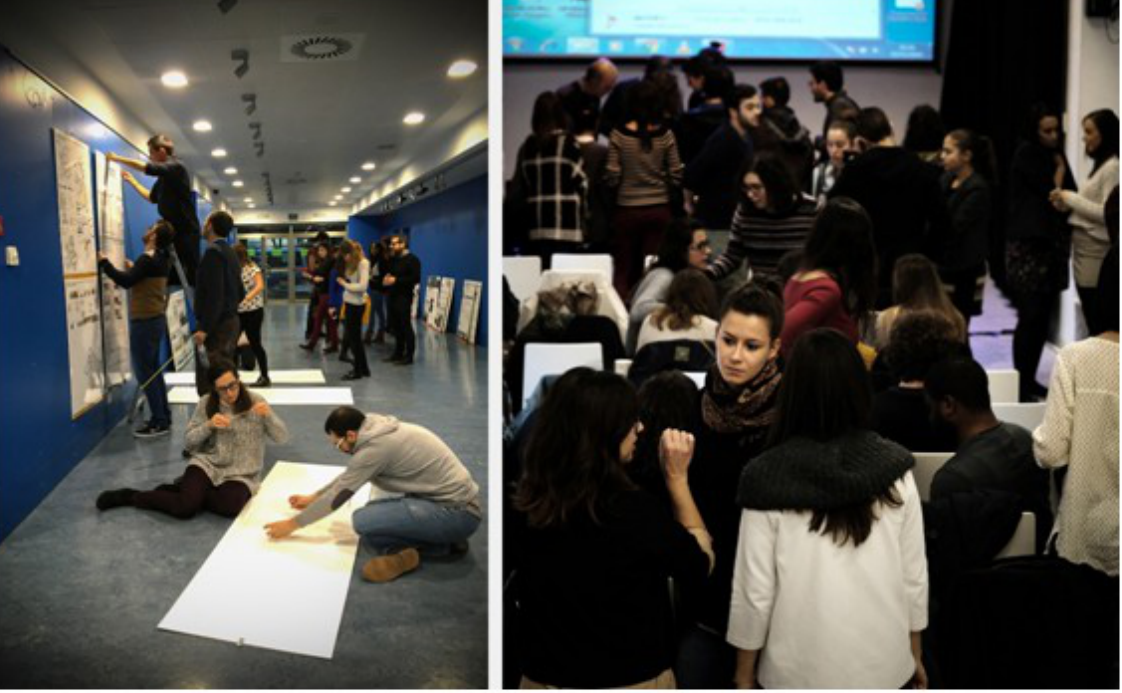
Figure 7. The “Ideas for a Better Neighbourhood” exhibition in the Civic Centre of the Oliver neighbourhood, and moments before presenting the results of the fourth workshop in La Harinera (San José